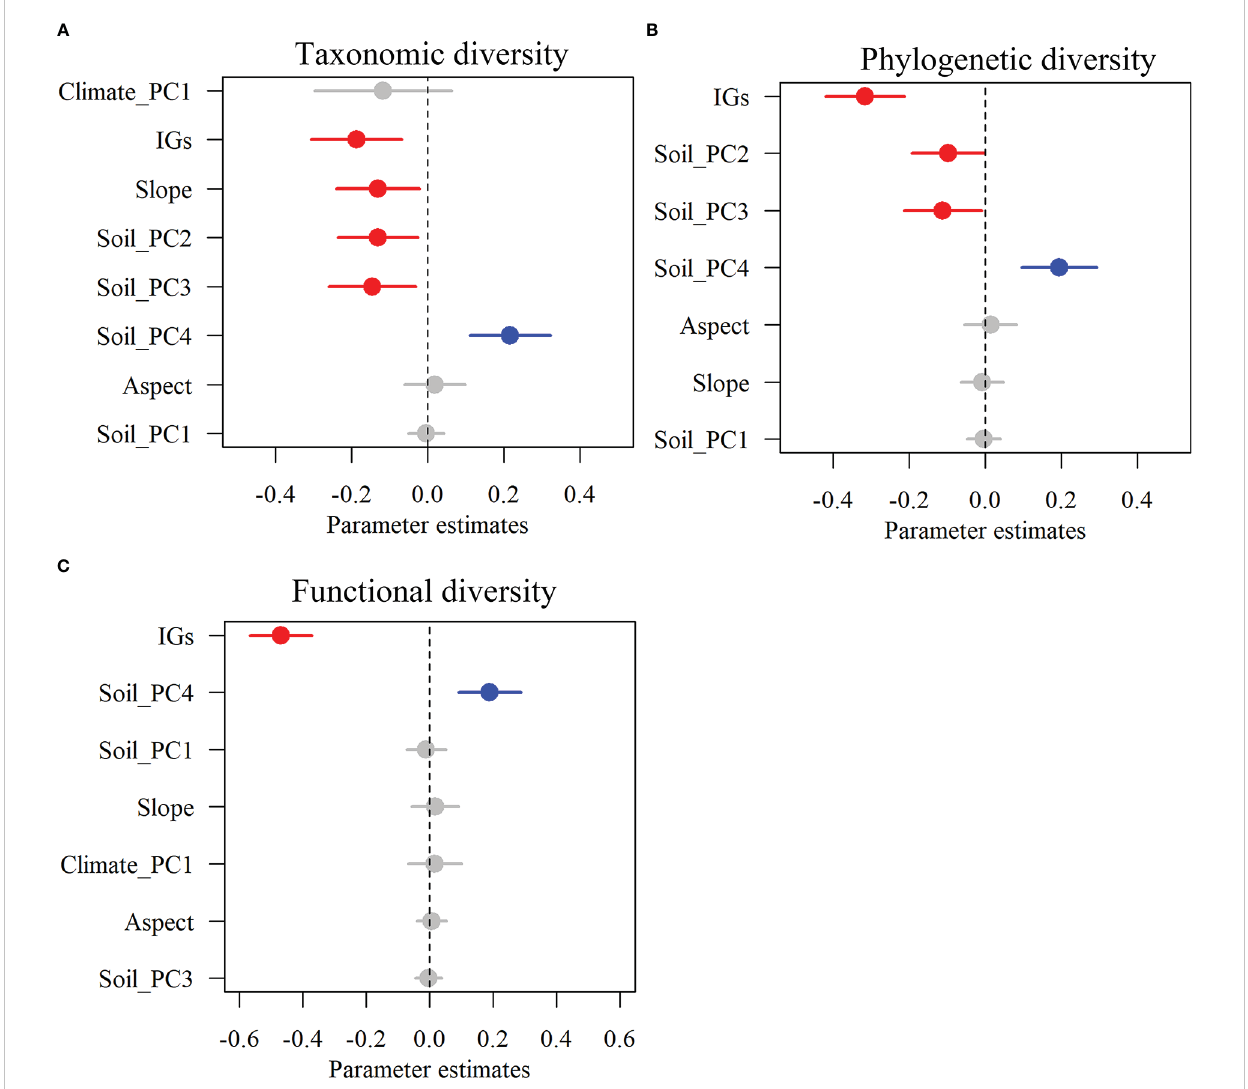
FIGURE 3 The effects of multi-dimensional variables on multifaceted plant alpha diversity. Taxonomic diversity (A) , phylogenetic diversity (B) , and functional diversity (C) . Dots with error bars denote the effect sizes and 95% con fi dence interval (CI), respectively. The blue and red colors represent signi fi cant positive and negative effects, respectively. Climate_PC1 (climate), Soil_PC1 (soil phosphorus), Soil_PC2 (soil nitrogen), Soil_PC3 (soil water content), Soil_PC4 (soil organic matter), Slope (slope), Aspect (aspect), and IGs (inundation